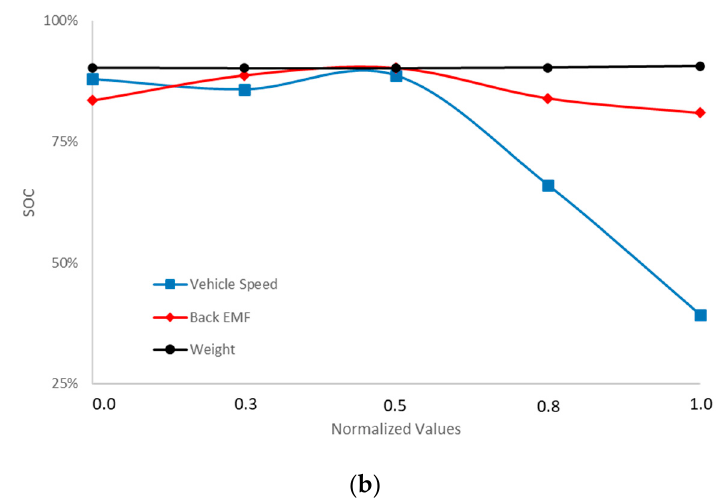
Figure 19. Effects of the parameters on ( a ) fuel consumption and ( b ) SOC.